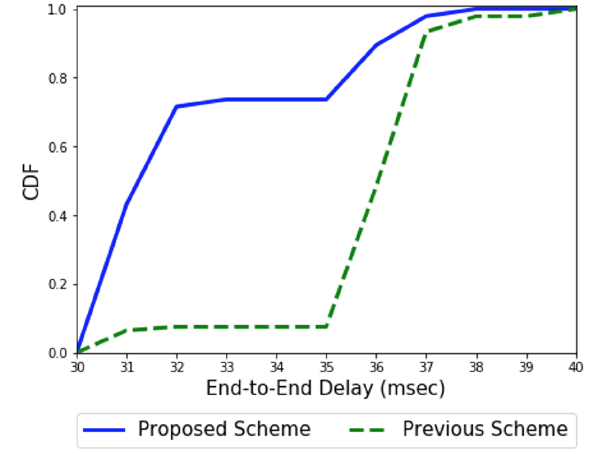
Figure 12. End-to-end delay in the false positive